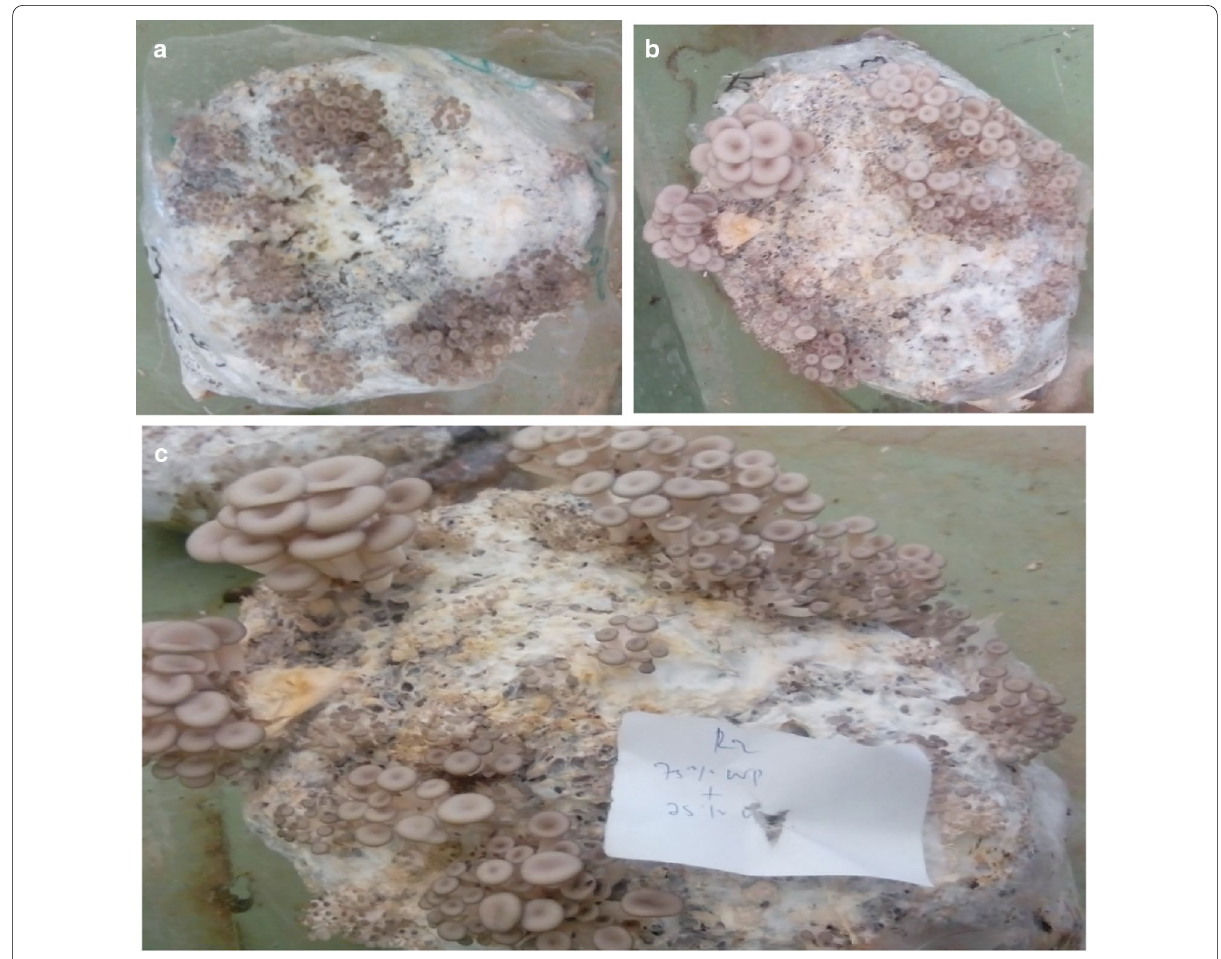
Fig. 1 Mycelia running ( a ), pin head formation ( b ), pining to maturation ( c )